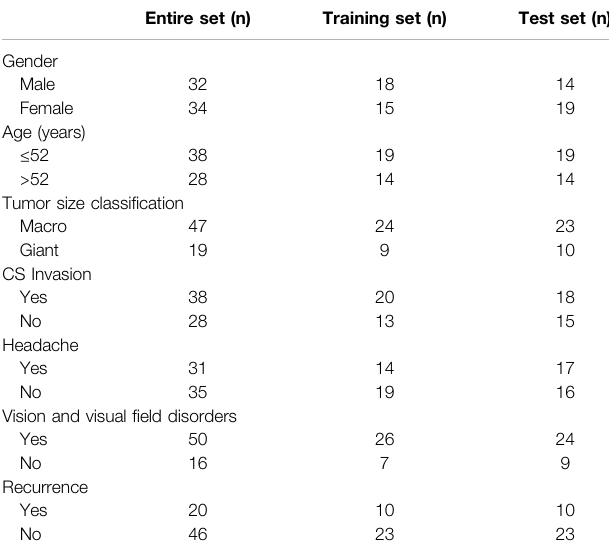
TABLE 1 | Clinical Data of the included